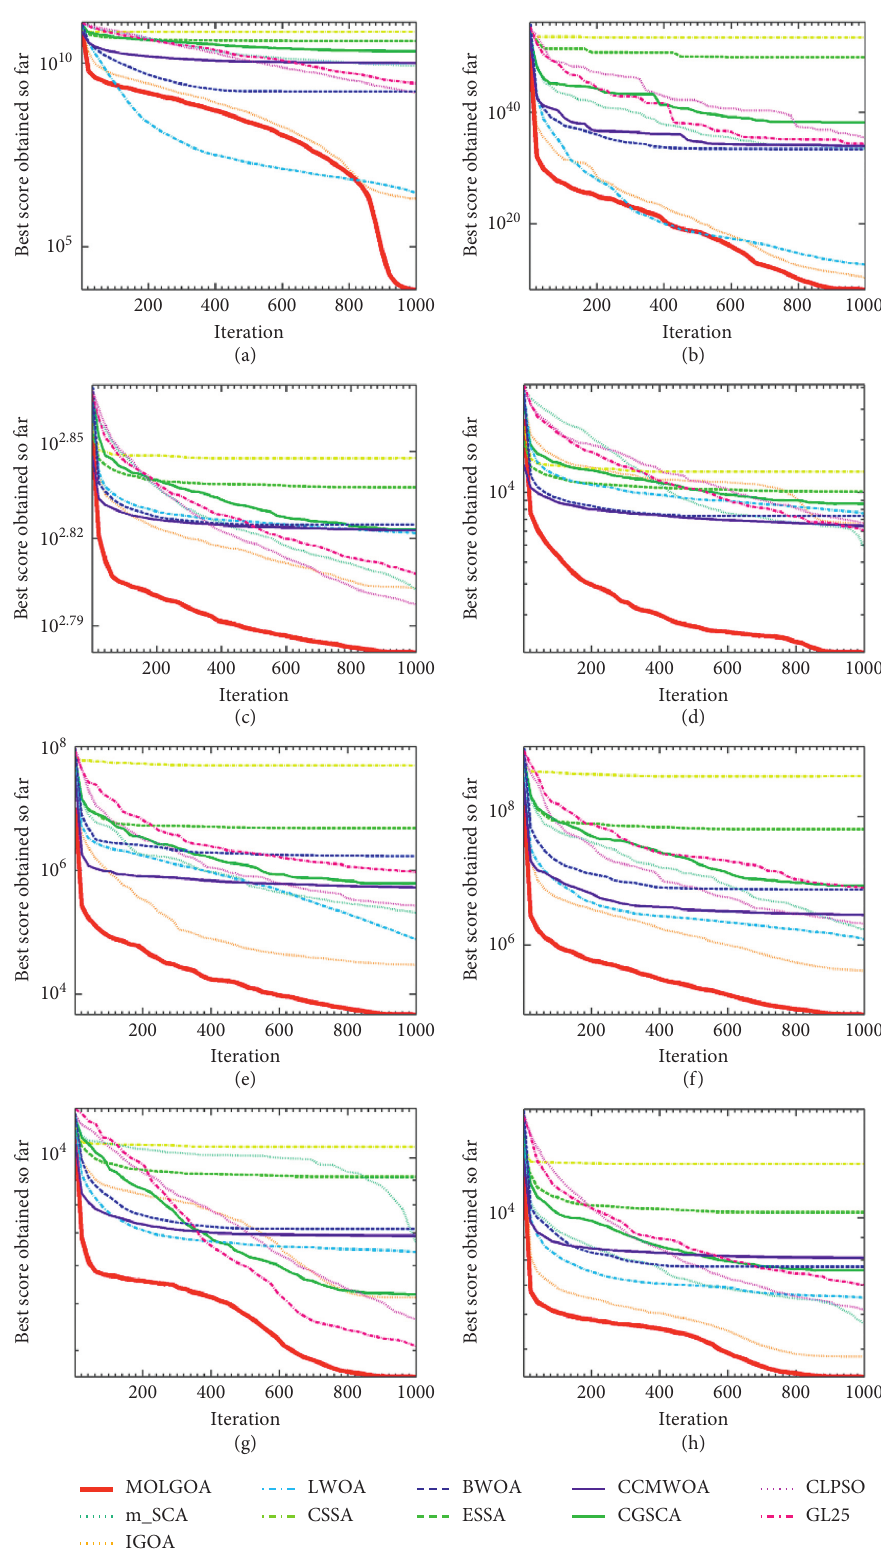
Figure 3: Convergence curve of MOLGOA and other variants algorithms (first row: (a) F 1, (b) F 2; second row: (c) F 6, (d) F 9; third row: (e) F 14, (f) F 18; fourth row: (g) F 22, (h) F